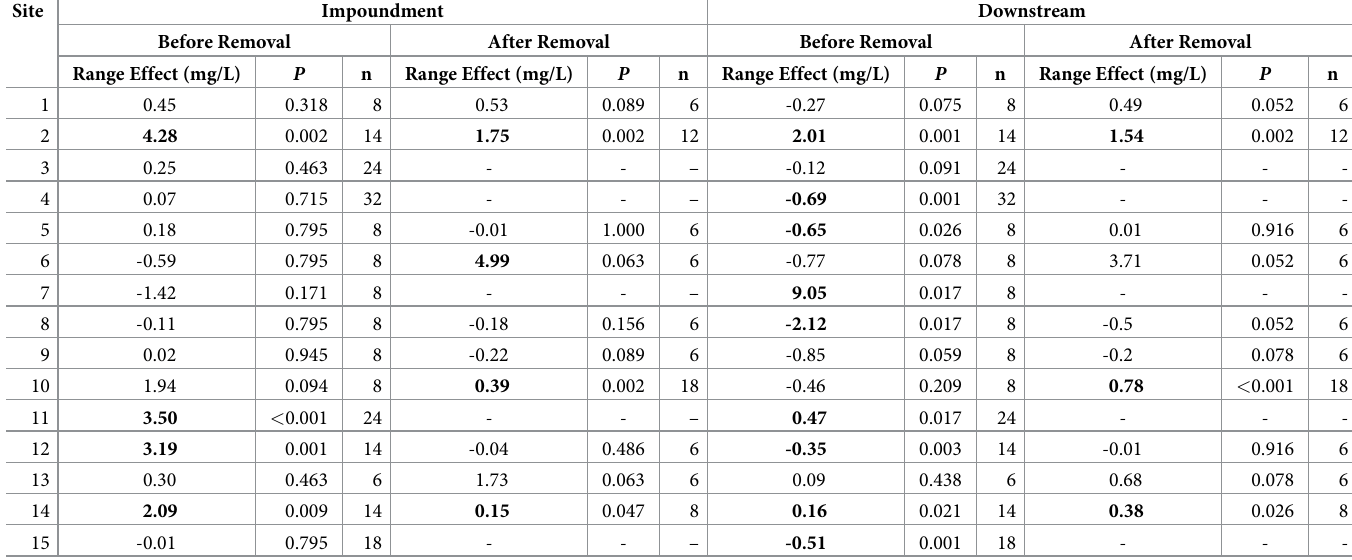
Table 5. Differences in dissolved oxygen (DO) diel ranges between impoundment and downstream reaches and upstream references before and after dam removal, termed impoundment or downstream range effect. Range effect is the average difference between diel ranges of impacted and upstream reaches. Positive values indicate a higher diel DO range relative to upstream.